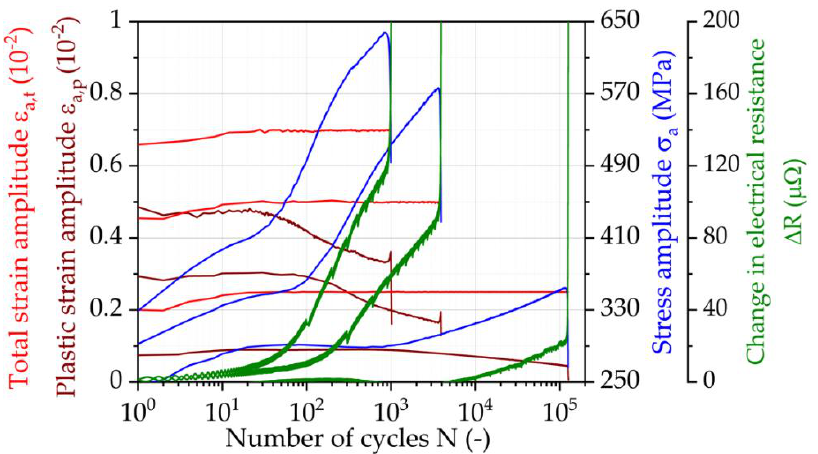
Figure 4. Change in electrical resistance ∆ R results of three CATs at RT with ε a , t = 0.25%, 0.50% and 0.70%.